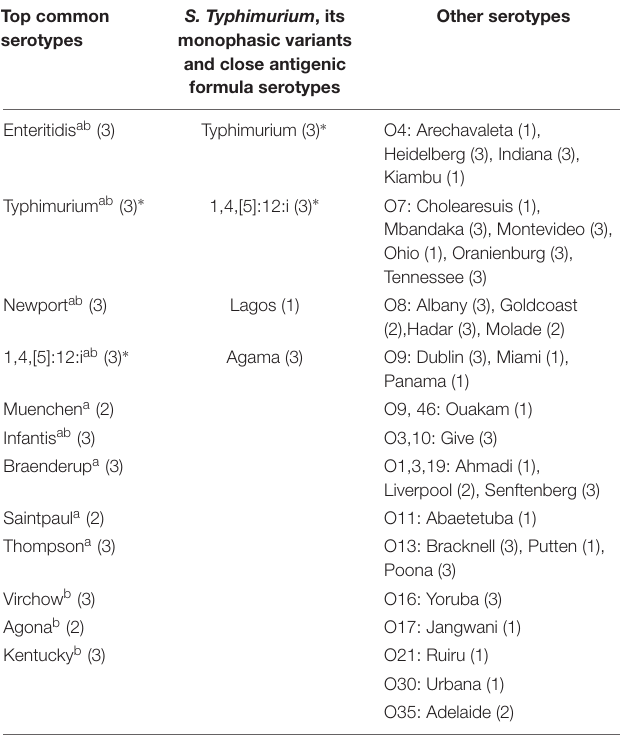
TABLE 1 | Strains used in this